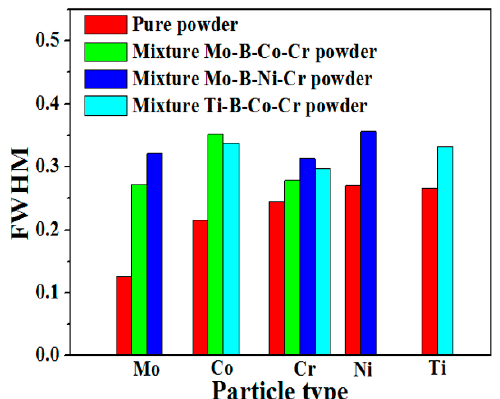
Figure 9. Full widths at half maximum (FWHMs) of Mo, B, Co, Ni, Cr, and Ti peaks in the pure and mixture powders.